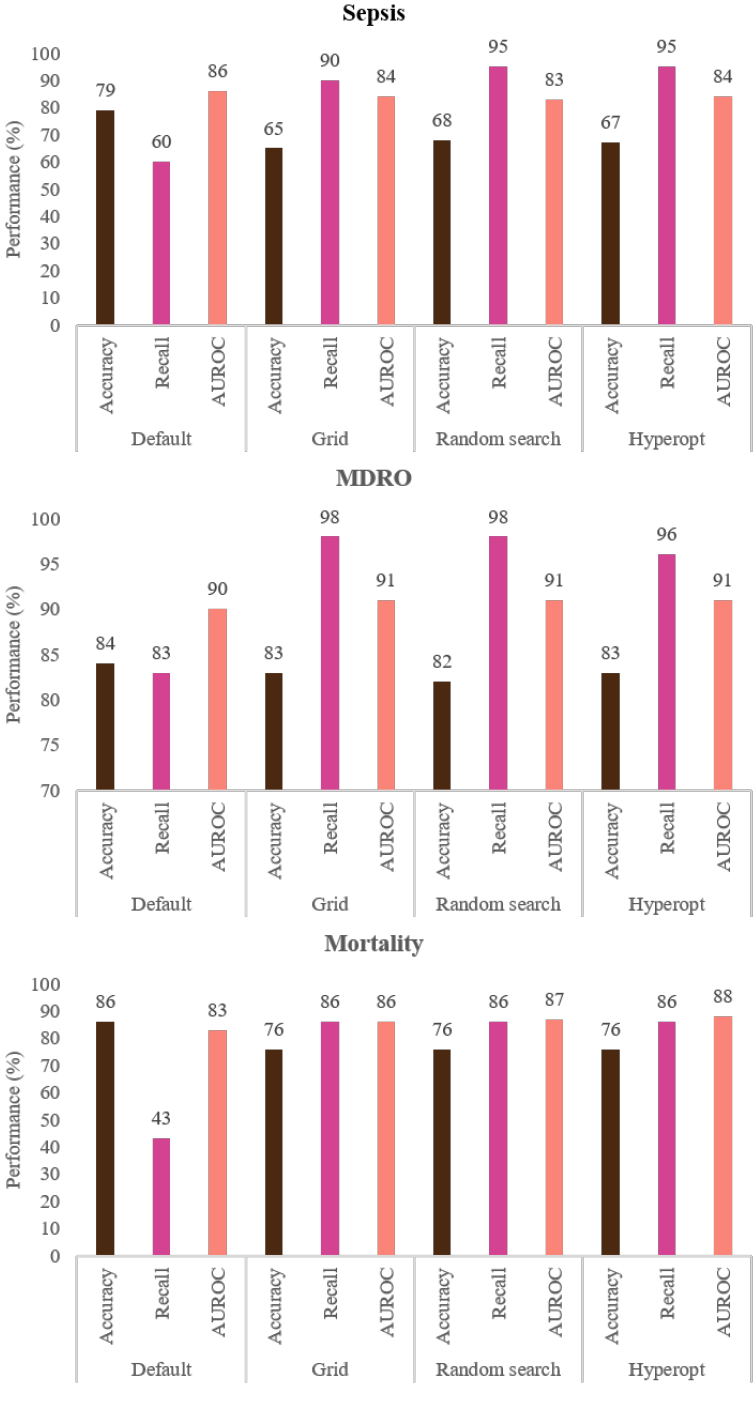
Figure 7. Shows the performance of the (1) default XGboost model before hyperparameter tuning, best model resulted from (2) grid search, (3) random search, and (4) Bayesian optimization (hyperopt) for each endpoint, obtained by using 5-fold stratified cross-validation with model scoring set to “recall”. Parameter n _ iter = 100 was set for random